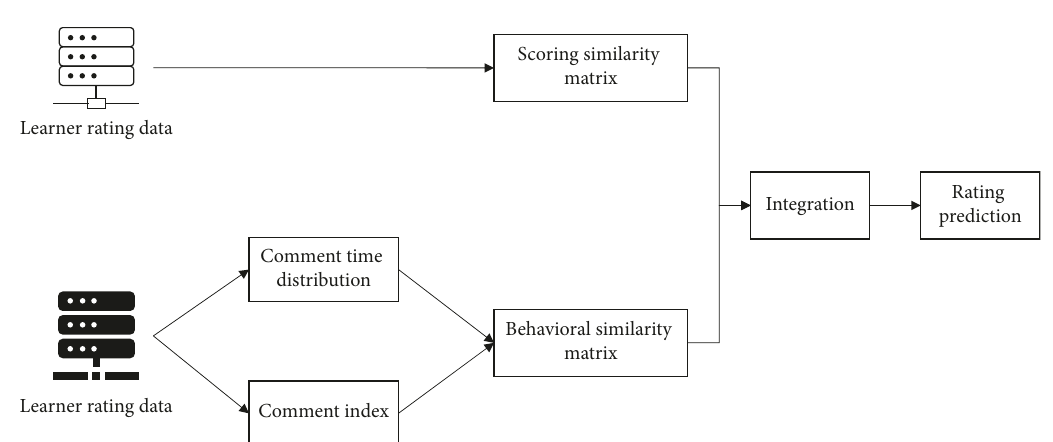
Figure 5: Framework of the improved collaborative filtering algorithm.